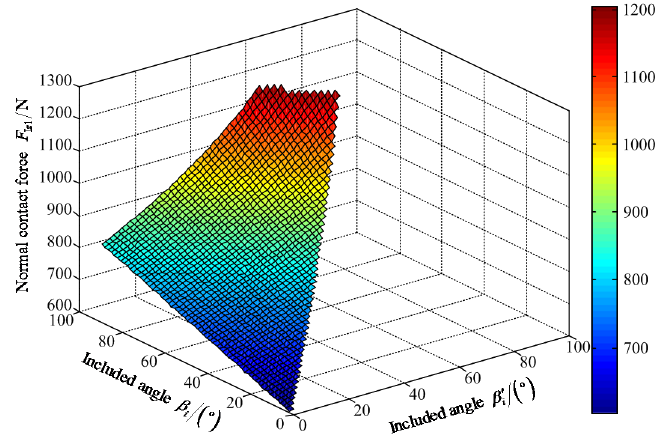
Figure 8. Variable tendency chart of normal contact force F I z 1 with changes of β i ′ and β i .